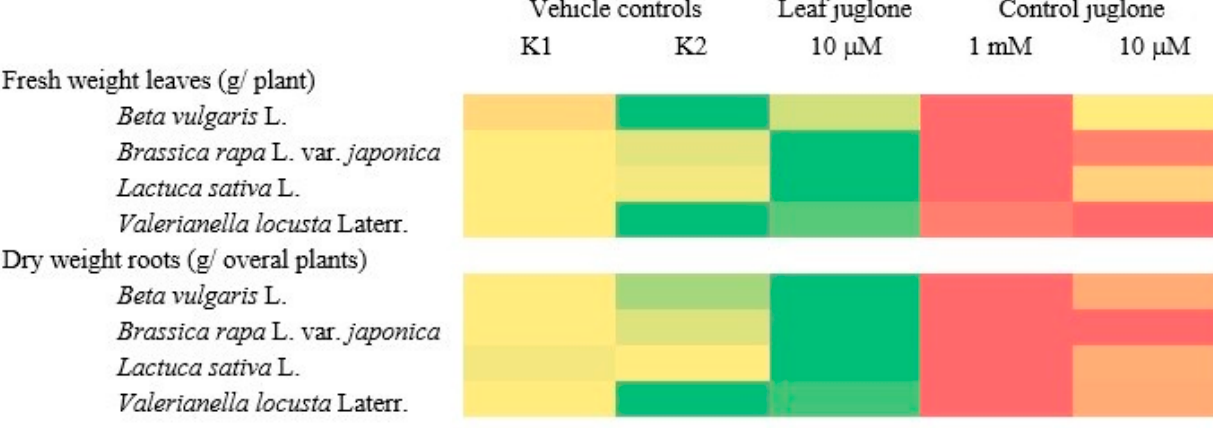
Figure 1. Heat map showing leaf fresh weights and root dry weights, from highest (green) to lowest (red) values between treatments (columns). K1: extraction medium control (0.17% DMSO, 0.17% ethanol in H 2 O); K2: water control.